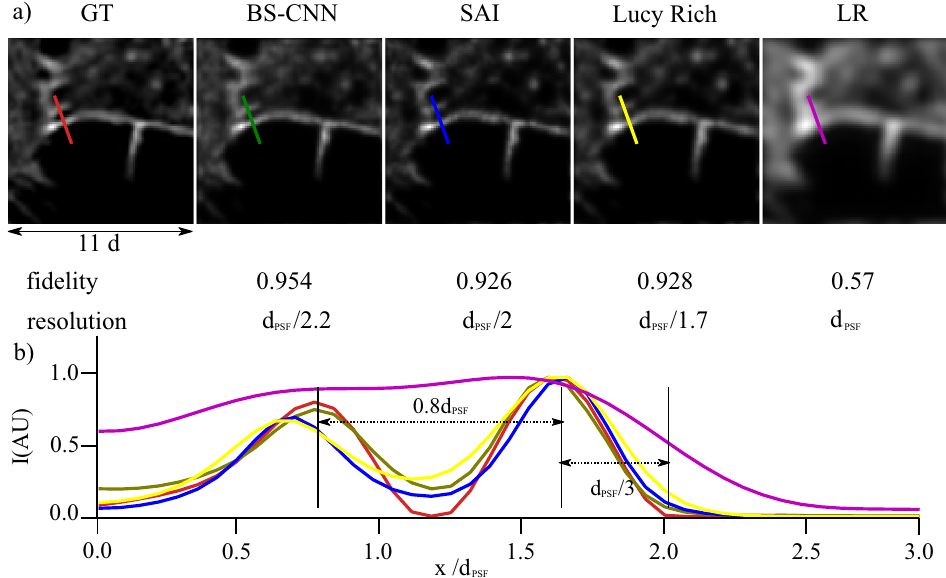
Figure 3. Comparison of different algorithms. In panel ( a ) the images from left to right are the ground truth GT, BS-CNN, SAI and Lucy Richardson (Lucy Rich.) deconvolutions of the low-resolution LR. All deconvolutions are for N =1000 and η =2.5. Below the images we label the Fidelity and the resolution expressed in terms of the PSF FWHM d PSF . In panel (b) we show the line profile for each algorithm which has length three times d PSF . The field of view for each image is 11 d PSF